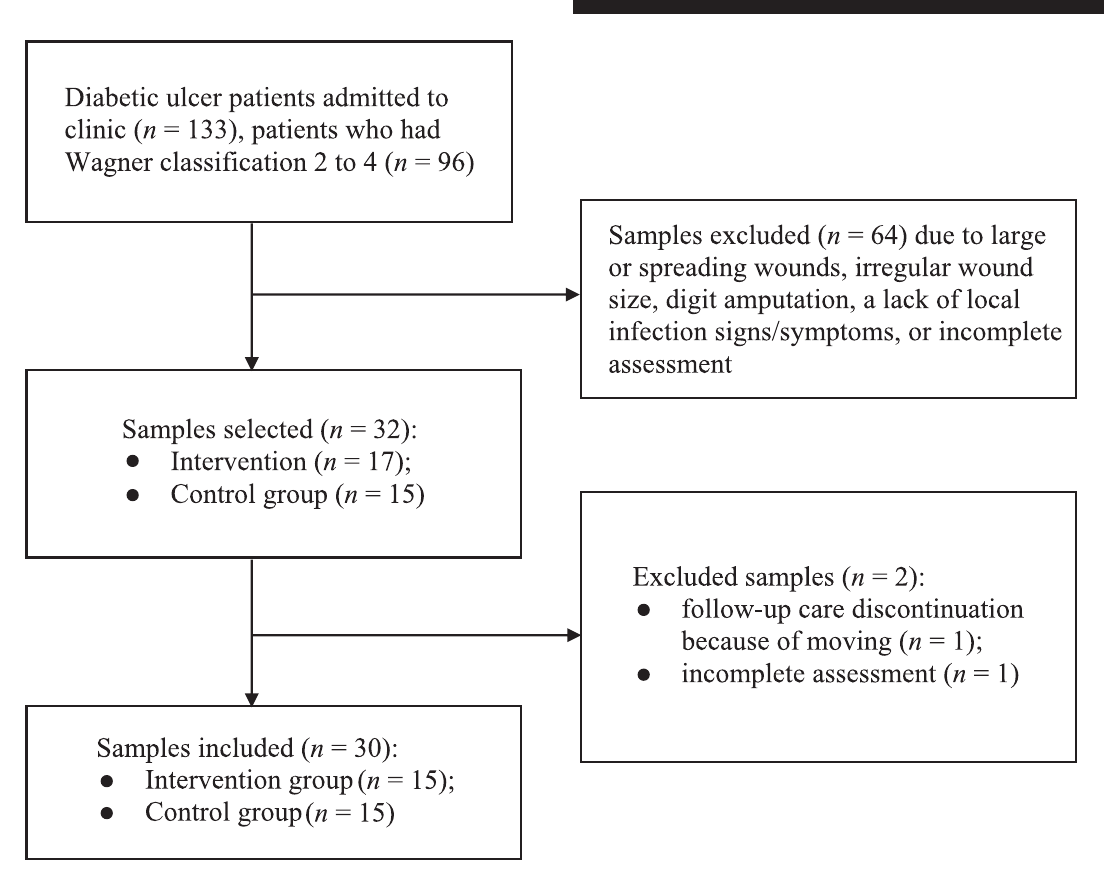
Figure 1. Flowchart of study participants.